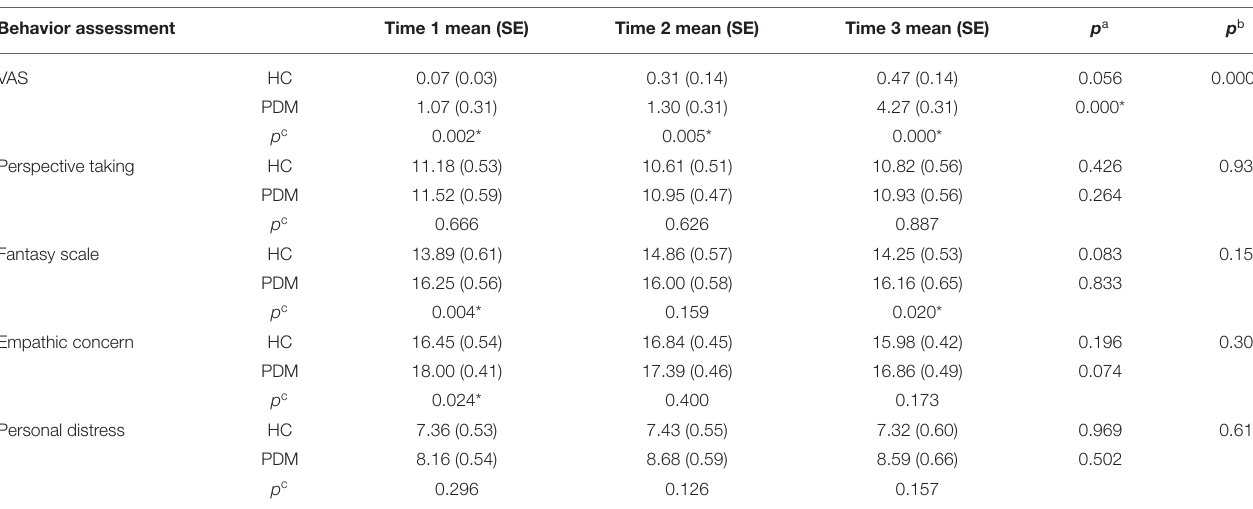
TABLE 2 | Clinical comparison at periovulatory, luteal, and menstruation phases. Behavior assessment